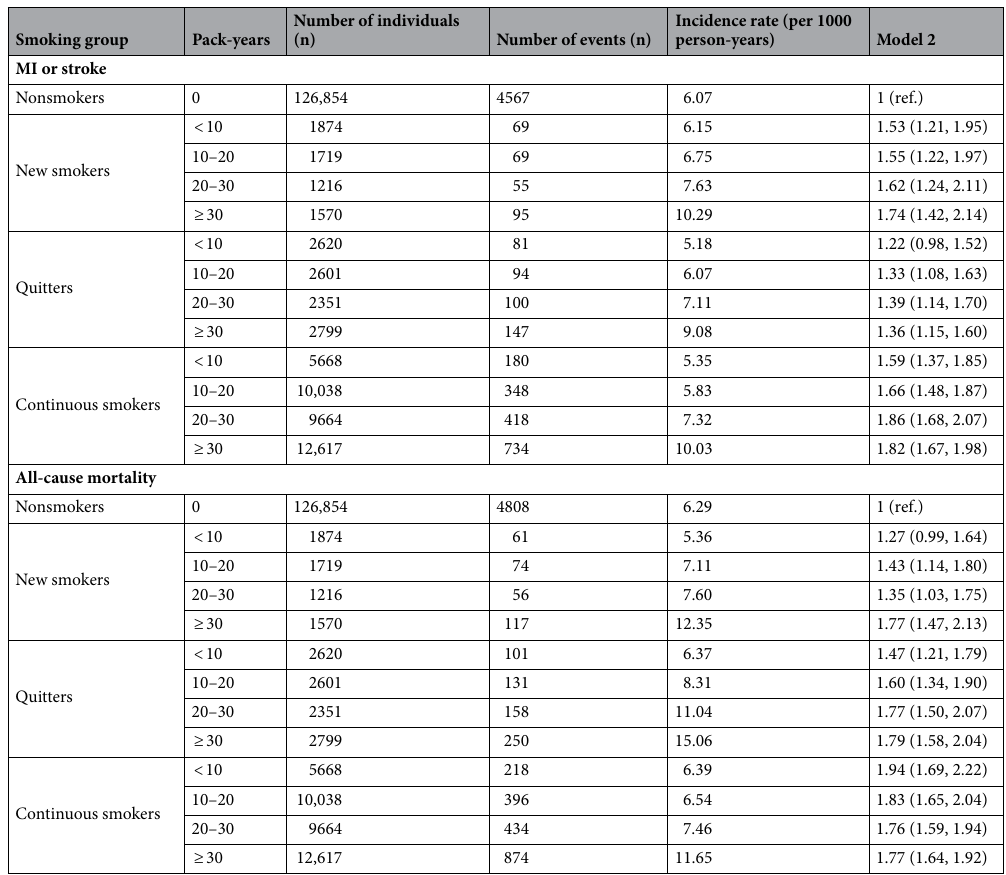
Table 4. Hazard ratios for myocardial infarction, stroke, and all-cause mortality in each group stratified by the smoking amount. The smoking amount of new and continuous smokers was calculated based on the questionnaire from the second health examination. The smoking amount of quitters was calculated based on the questionnaire at the first health examination because they had quit smoking before the second